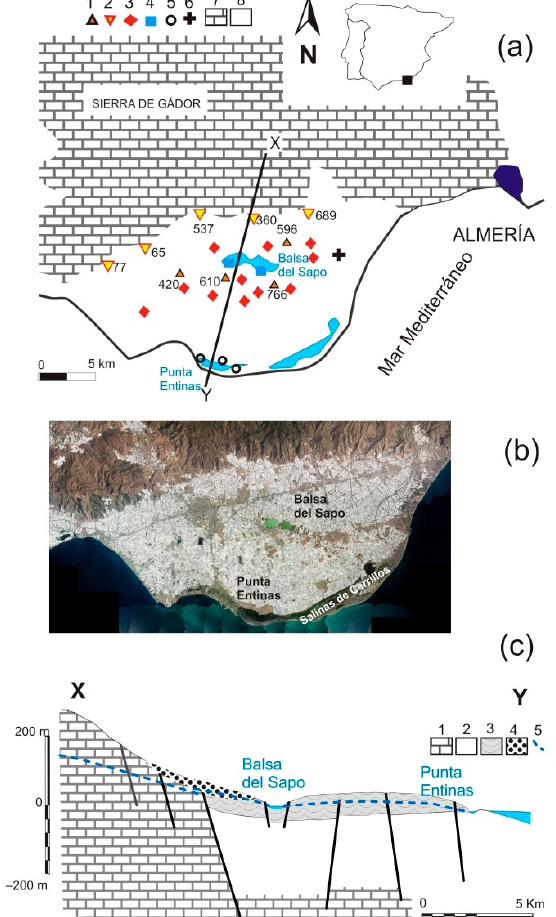
Figure 1. ( a ) Simplified geological map of Campo de Dalías showing the two wetlands and the location of the monitoring points. Water table (1: shallow aquifer, 2: deep aquifer), chemistry (3: shallow aquifer, 4: Balsa del Sapo, 5: Punta Entinas), 6: La Mojonera rainfall station, 7: carbonate deposits (limestone and dolostone), 8: neogene detritic materials. The X-Y line identified the location of the cross-section presented in C. The location of the study area is marked with a square on the map. ( b ) Image of the Campo de Dalías. All the area in white is covered by greenhouses. Date 2016. Source: Plan Nacional de Ortograf í a. Government of Spain. ( c ) Schematic geological cross- section. 1: Carbonate deposits (limestone and dolostone); 2: impermeable materials (marl and silt); 3: calcarenite; 4: gravel. 5: water table. Based on